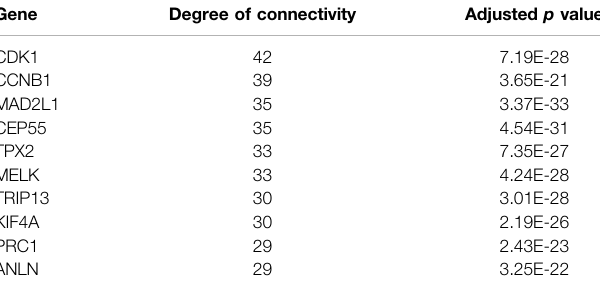
TABLE 1 | Top 10 hub genes with higher degree of